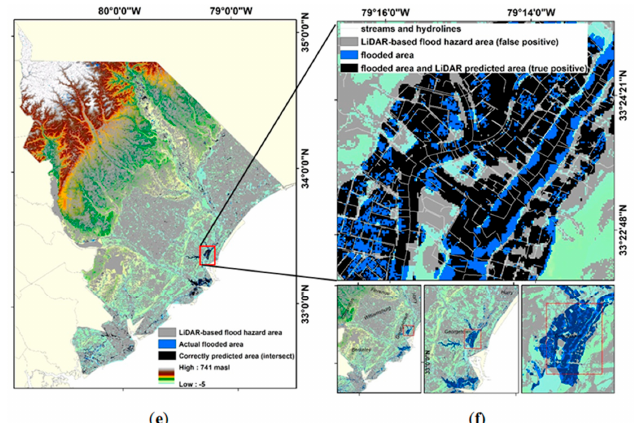
Figure 7. Model results of IDW interpolation flood hazard area analysis: ( a ) shows the LiDAR-based DEM, which is the primary source of elevation points; ( b ) shows the geographic extent of the streams and hydrolines as source of the height above river (HAR); ( c ) shows the spatial distribution of flood hazard areas analyzed using an optimized configuration of IDW with 1000-m distance interval of sampling points within the stream; ( d ) a closer visualization of the sampling points within the streams; ( e ) shows how the flood hazard areas layout across the region while overlay with the predicted flood and the LiDAR-based DEM, and the black-shaded areas also show the intersect between the predicted floodplains and the flooded area; ( f ) shows a closer visualization of the flood hazard areas and how the streams and hydrolines have influenced the spatial distribution of flood hazard areas. Using high-resolution LiDAR-based DEMs as data inputs produced highly detailed raster images. Resampling all inputs and outputs to 9 m × 9 m per pixel produced an intricate map without compromising the processing power of the ArcGIS software. The detailed output maps allow for a smaller scale and more thorough analyses of the flood hazard areas (Figure 8b–e).